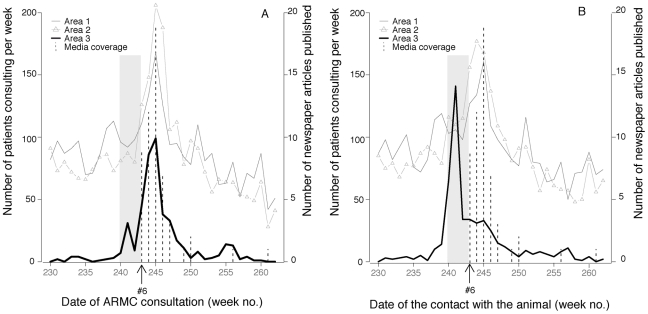
Comparison of the different behaviors observed in the different geographical areas.Keep in mind that event #6 occurred in area 3. The grey band corresponds to the rabid dog's infectious period (weeks 240–242).